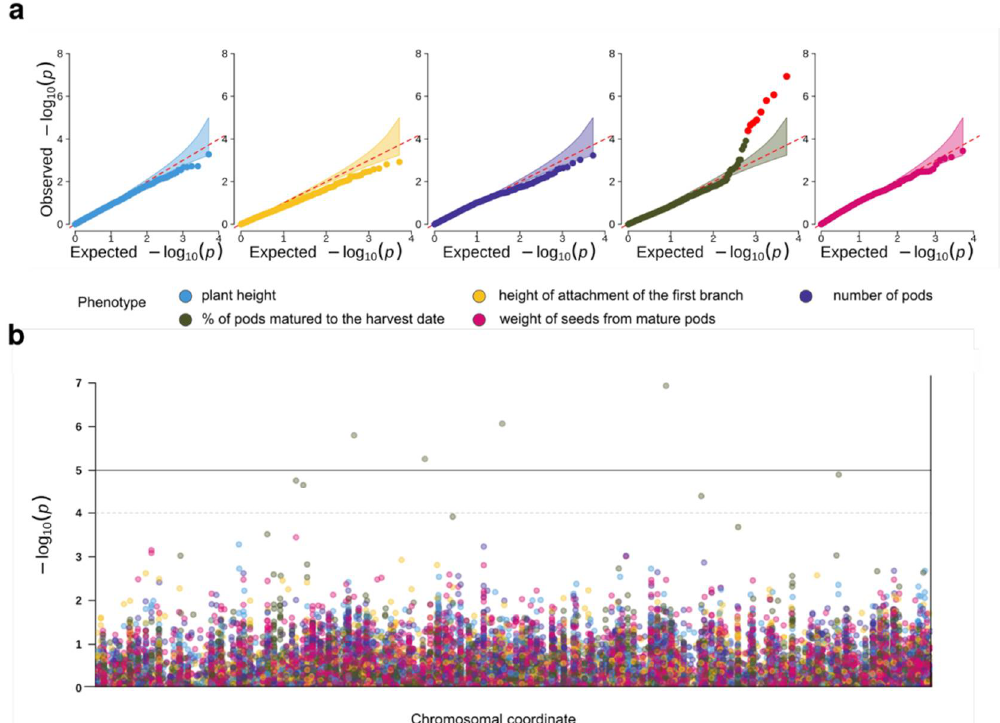
Figure 3. Genome-wide association analysis of productivity-related traits in guar. ( a ) Quantile–quantile plots for the association p -values against indicated traits. Envelope corresponds to the 95% confidence interval for the expected value. Variants reaching significance level of p < 1 × 10 − 4 are highlighted in red. ( b ) Manhattan plot showing association p -values for all indicated traits. Thresholds correspond to the call set-wide significance (bold line, 1 × 10 −5 ) and sub-significance threshold (dashed line, 1 × 10 −4 ). Colors of the points correspond to traits.